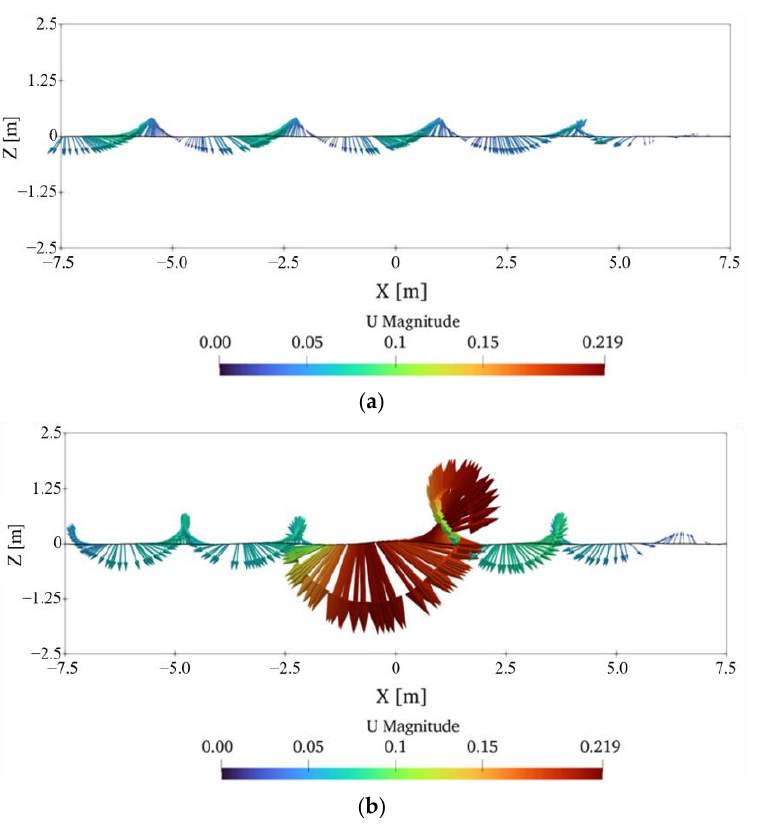
Figure 17. Velocity vectors on a free surface at y = 0 plane: ( a ) regular wave; ( b ) rogue wave.